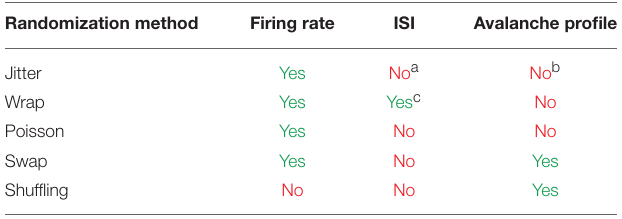
TABLE 1 | List of data features preserved under randomization for each randomization